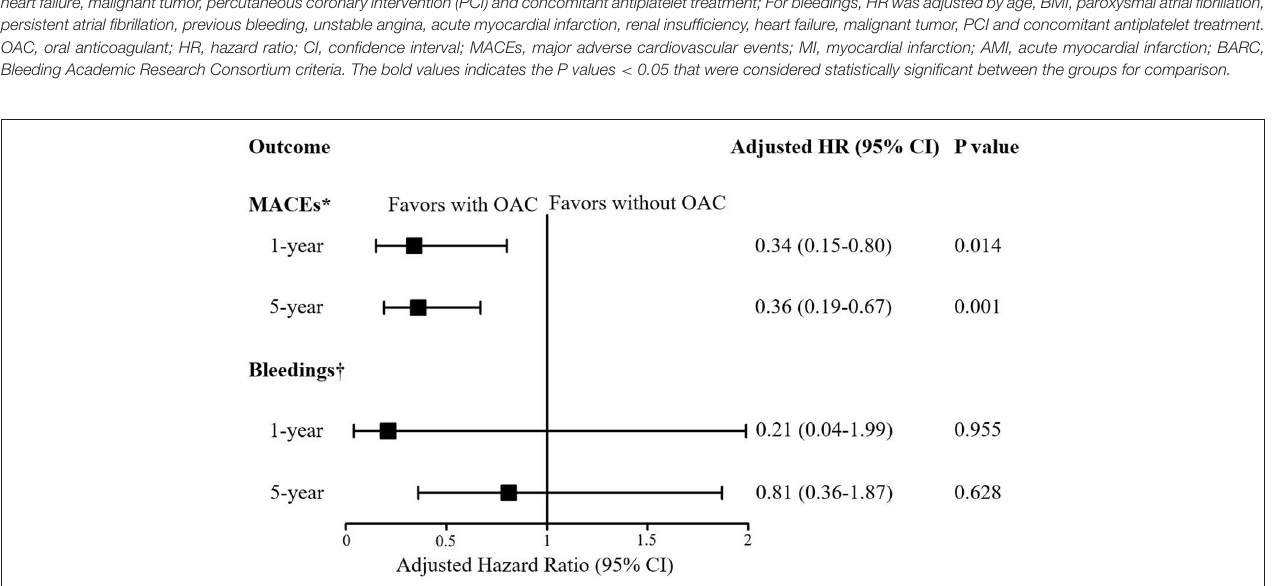
FIGURE 4 | Forest plot for the risk of MACEs and bleedings in patients with or without OAC according to the length of follow-ups. *For MACEs, HR was adjusted by the variables including age, BMI, paroxysmal atrial fibrillation, persistent atrial fibrillation, unstable angina, acute myocardial infarction, renal insufficiency, heart failure, † malignant tumor, percutaneous coronary intervention (PCI) and concomitant antiplatelet treatment; For bleedings, HR was adjusted by age, BMI, paroxysmal atrial fibrillation, persistent atrial fibrillation, previous bleeding, unstable angina, acute myocardial infarction, renal insufficiency, heart failure, malignant tumor, PCI and concomitant antiplatelet treatment. HR, hazard ratio; CI, confidence interval; MACEs, Major Adverse Cardiovascular Events; Bleeding was defined as BARC ≥ 2; OAC, oral